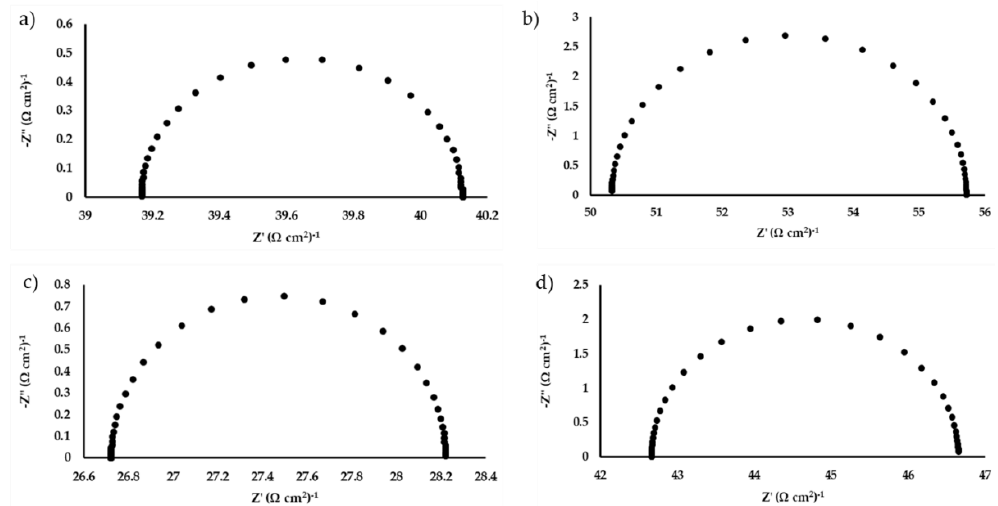
Figure 8. Electrochemical impedance spectra of DCFC for chemically treated rubber wood biochar: ( a ) pre-treated alkali RW; ( b ) pre-treated acid RW; ( c ) post alkali RW; ( d ) post acid RW.